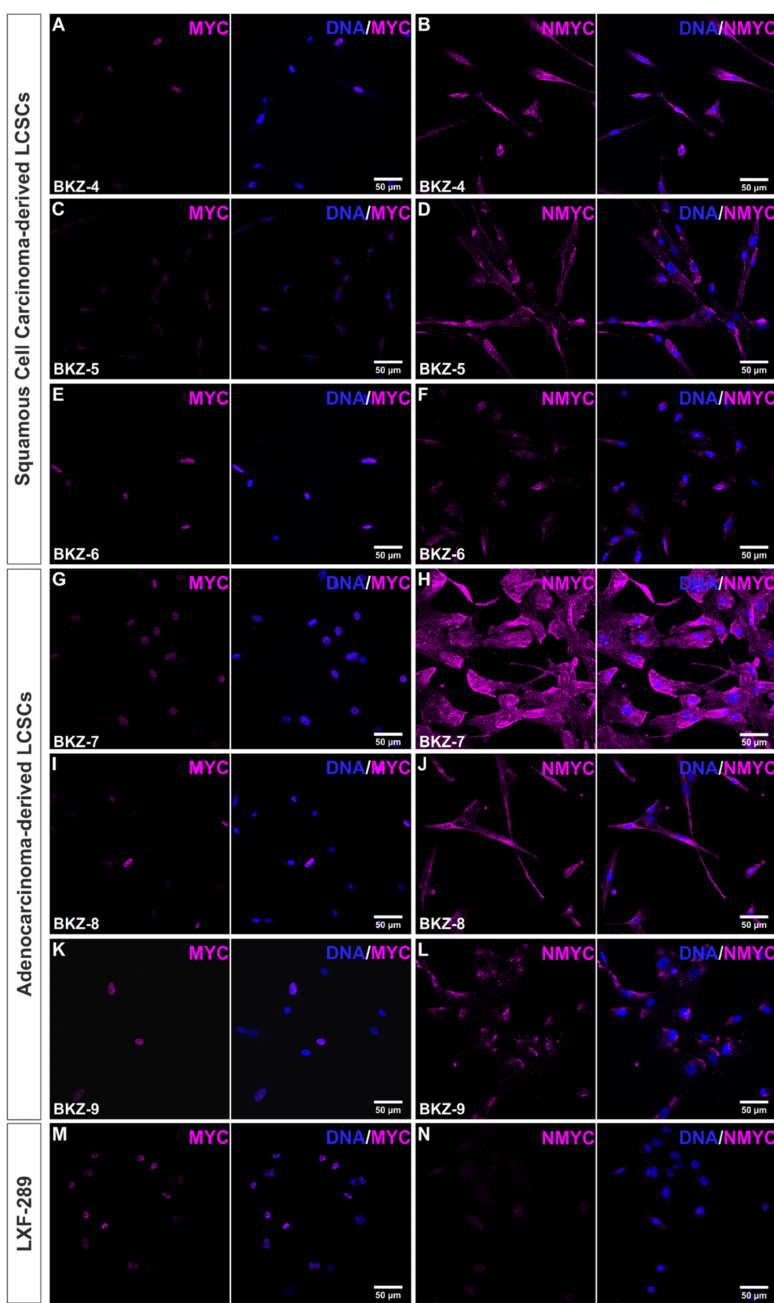
Figure 4. Squamous cell carcinoma- and adenocarcinoma-derived lung cancer stem cell-like cells all expressed myc proto-oncogene (MYC) and N-myc proto-oncogene (NMYC) at the protein level. Anal- ysis of the protein expression of the oncogenes via immunocytochemical staining depicted a nuclear expression of ( A , C , E , G , I , K ) MYC and a predominantly cytosolic expression of ( B , D , F , H , J , L ) NMYC for all cell populations. Immunocytochemical analysis of the well-established lung adenocarcinoma- derived cell line LXF-289 depicted nuclear ( M ) MYC expression, as well as slight cytosolic expression of ( N )